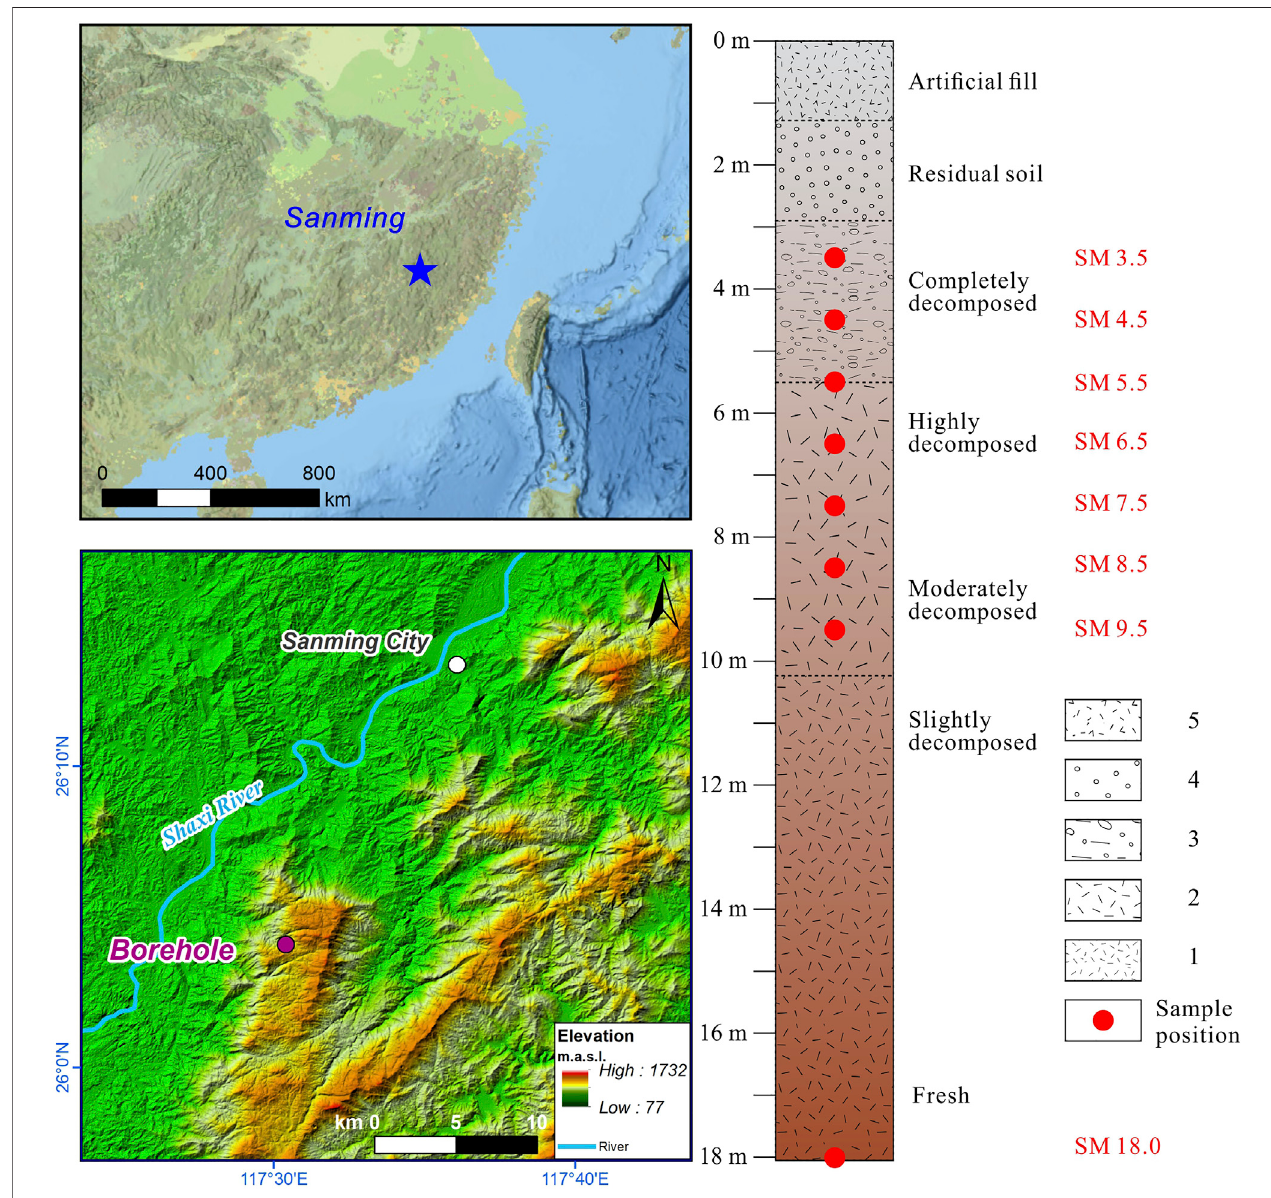
FIGURE 1 | The top left map shows the location of Sanming in China. The topographic map on the lower left shows the exact location of the borehole in Sanming. The DEM raster data were obtained from AW3D30 of JAXA (Takaku et al., 2020). The schematic diagram on the right shows the Sanming borehole. 1 – 5 in the legend indicate different degrees of